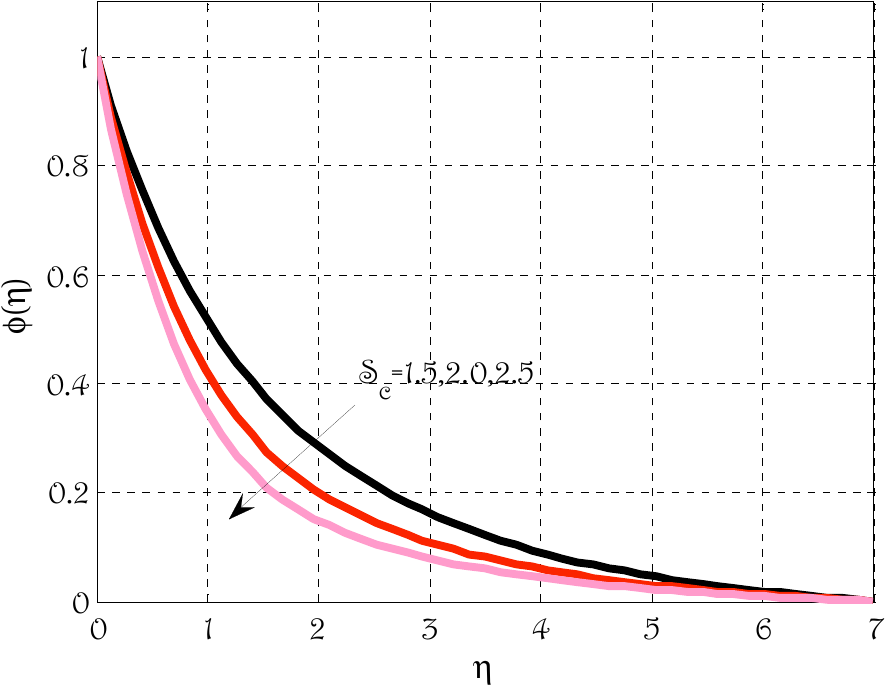
Figure 10. Effect of Schmidt number S c on concentration profile φ using k p = 0.5, M = 0.5, E c = 0.4, λ = 0.1, N t = 0.1, N b = 0.1, P r = 1.5, R d = 0.7, γ = 0.1.